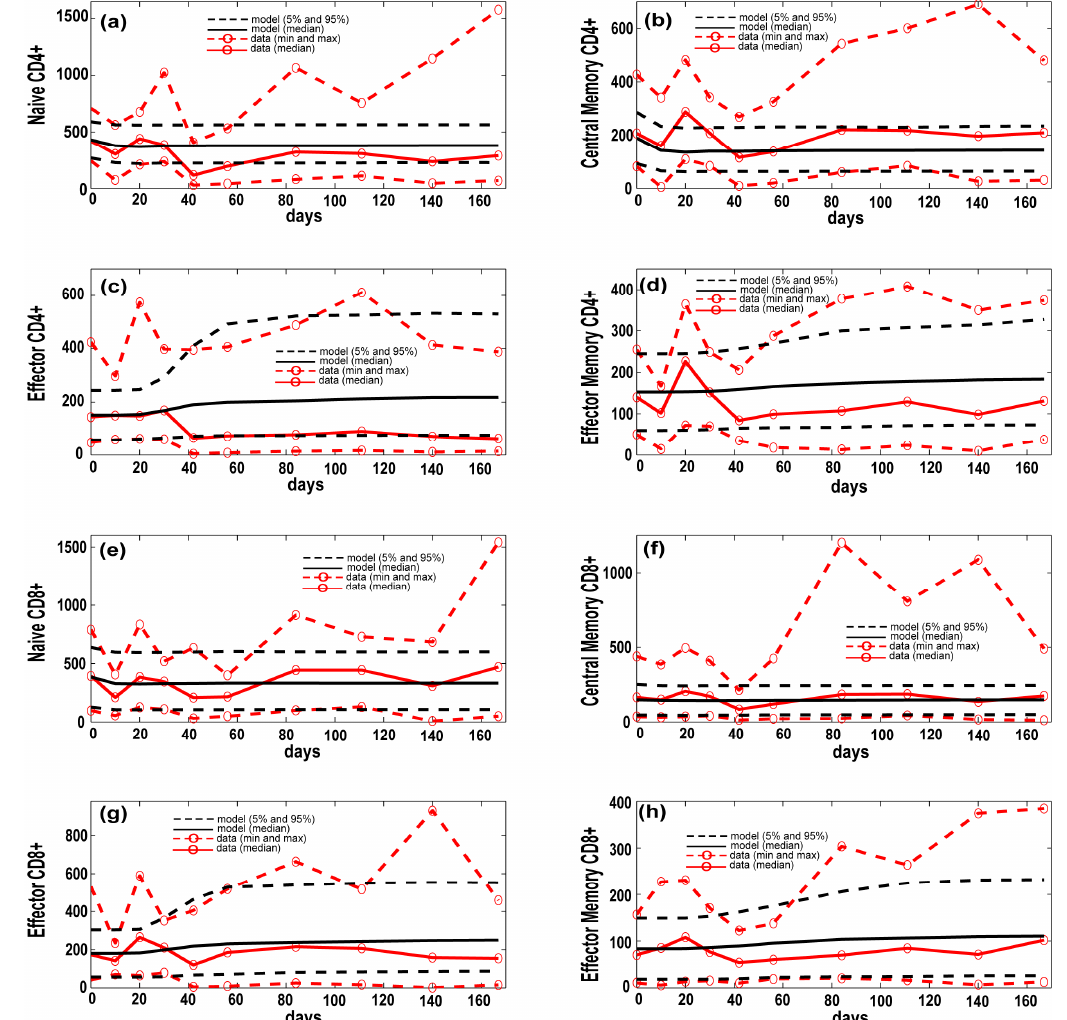
Figure 4. Computational model calibration (blood compartment). NHP experimental data on blood T cell phenotypes (see Supplementary File 3) are plotted here versus the in silico datasets of blood T cell phenotypes (blood compartment), from our computer simulations of 3000 granulomas coupled to the blood and LN dynamics. The x -axis shows a time span of infection up to 200 days to match the NHP blood data. The y -axis represents cells/cm 3 . ( a – h ) In silico dataset of 3000 time courses of 8 T cell classes generated in the blood compartment (black solid line [mean] and black dashed lines [5th and 95th percentiles]) compared to experimental data on T cell phenotypes in the blood of Mtb-infected NHPs (red dashed lines with red open circles, representing the min and max). For the minimum and maximum of the NHP data we chose the lowest and highest values at any time point across all the NHPs. In silico predictions are displayed as median (black solid line) and minimum and maximum (dashed black lines). We show Naïve CD4+ T cells ( a ) and CD8+ T cells ( e ); Central Memory CD4+ T cells ( b ) and CD8+ T cells ( f ); Effector CD4+ T cells ( c ) and CD8+ T cells ( g ) and Effector Memory CD4+ T cells ( d ) and CD8+ T cells ( h ). The in silico data have been obtained by summing the respective Mtb-specific and non Mtb-specific equations of the blood compartment of the computational model [36].